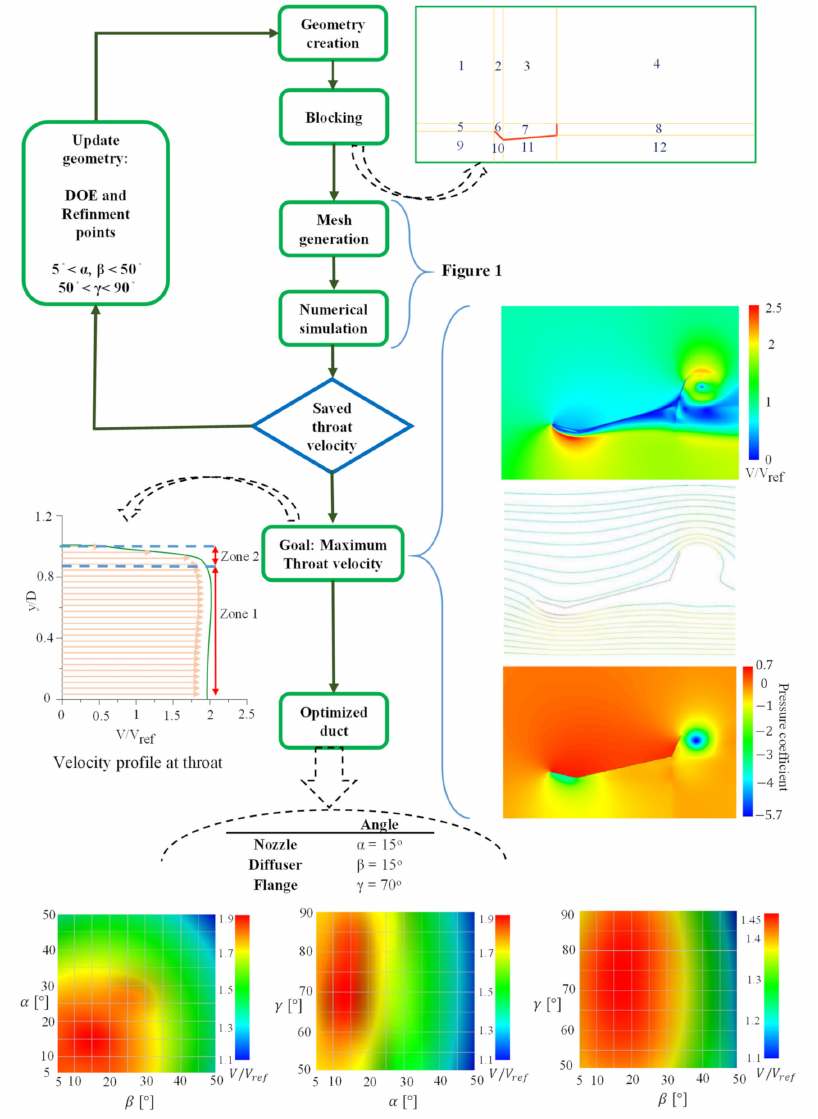
Figure 2. Optimized duct algorithm and final duct